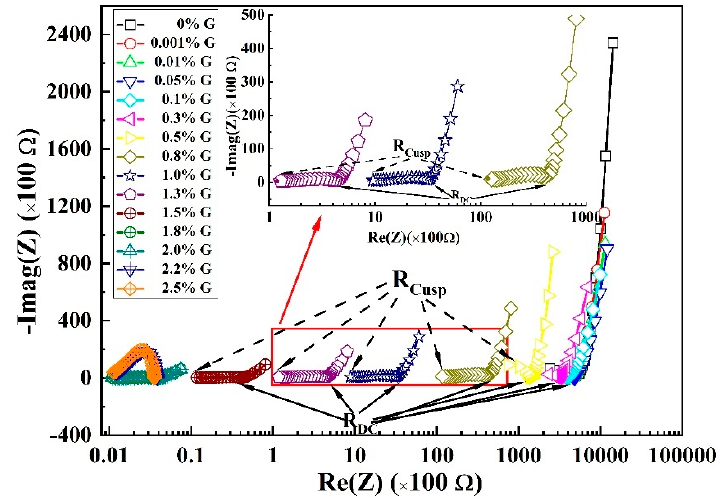
Figure 3. Nyquist curves obtained by AC measurement for graphene/cement composites with various graphene contents.